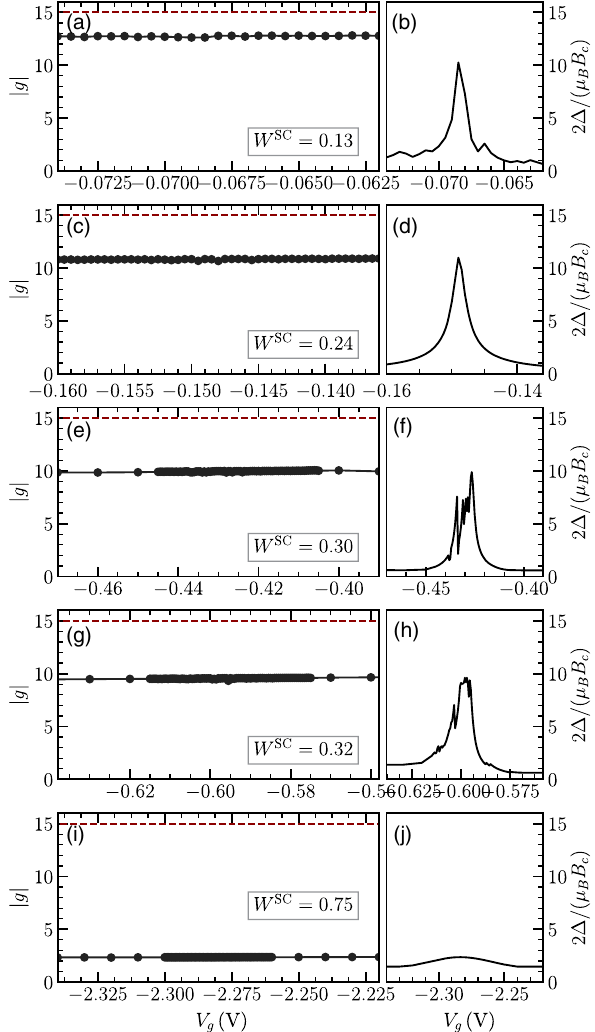
FIG. 10. Absolute value of g factor (left-hand column) and ratio of the induced gap to the critical magnetic field 2 Δ = ð μ (right-hand column) as a function of gate voltage in the vicinity of threshold gate voltage values V − 0 . 45 (e),(f), − 0 . 6 (g),(h), − 2 . 3 (i),(j) at which the number of subbands change in the system. The red dashed line is the absolute value of bare semiconductor g factor j g bare